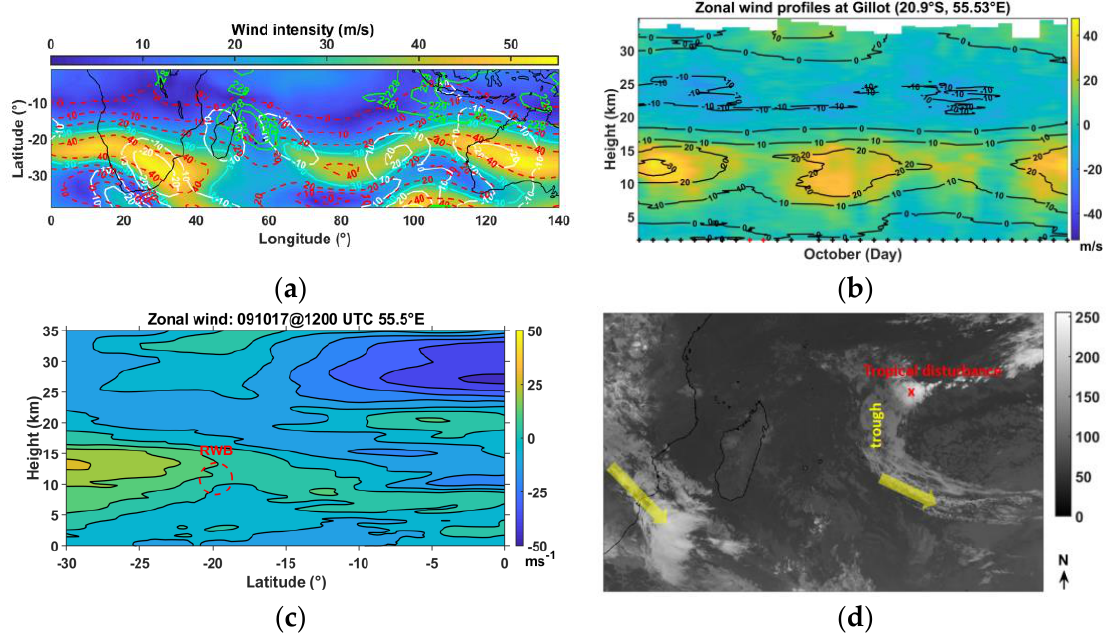
Figure 12. ( a ) Wind intensity derived from WACCM at 11 km height at 1200 UTC on 9 October 2017. Contours highlight zonal wind (dashed red), meridional wind (white), wind intensity (cyan) in m/s and temperature in K (green). Heating is located above La Réunion; ( b ) Distribution of zonal wind and isocontours in October 2017 from radiosonde data. Black crosses on the time axis indicate available radiosounding profile and red crosses locate days 9 and 10 October; ( c ) Latitude–height distribution of zonal wind at longitude of 55.5°E on 9 October at 1200 UTC during austral winter derived from ERA5 (137 levels). The broken red circle locates the RWB; ( d ) Meteosat 8 IR image (gray levels) on 10 October 2017 at 1100 UTC and the locations of the jet (yellow arrows), the tropospheric trough and the tropical disturbance (Météo-France).